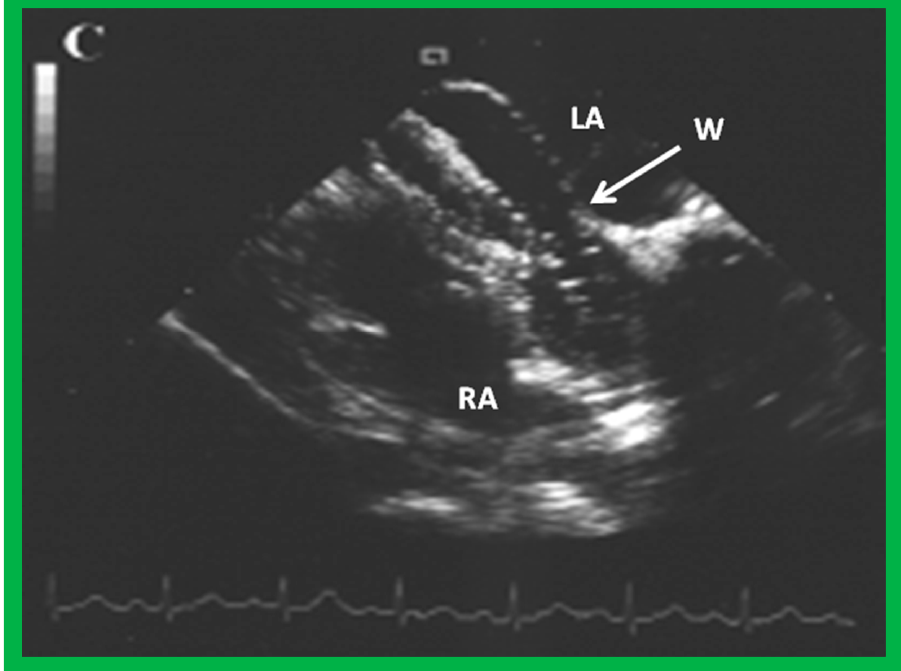
Figure 23. Trans-esophageal echocardiogram demonstrating static balloon sizing of an atrial defect. Waist (W) of the balloon is seen, which measures the size of the ASD. LA, left atrium; RA, right atrium. Reproduced from Reference [4].